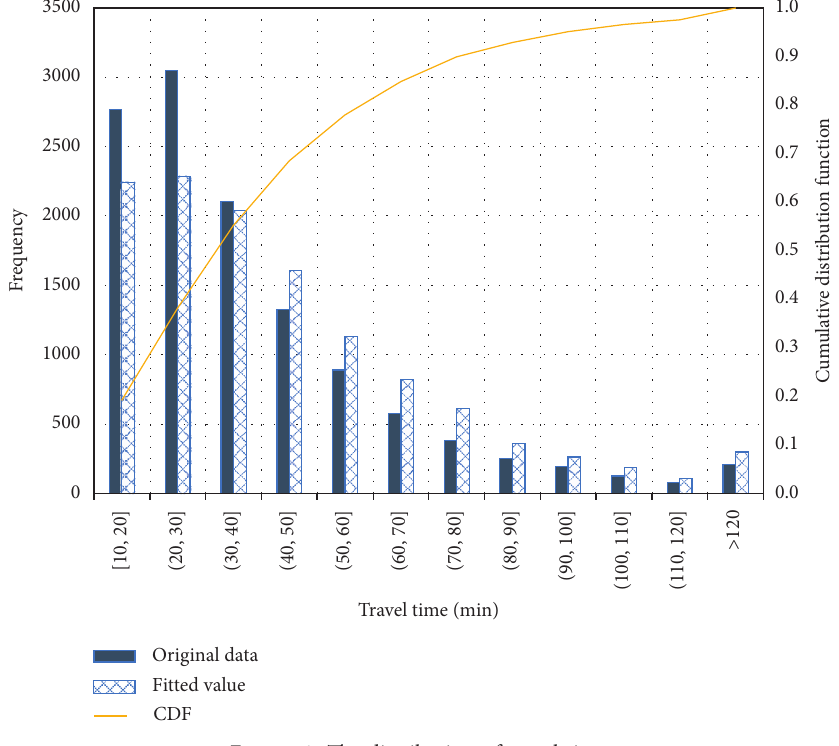
Figure 2: The distribution of travel time.